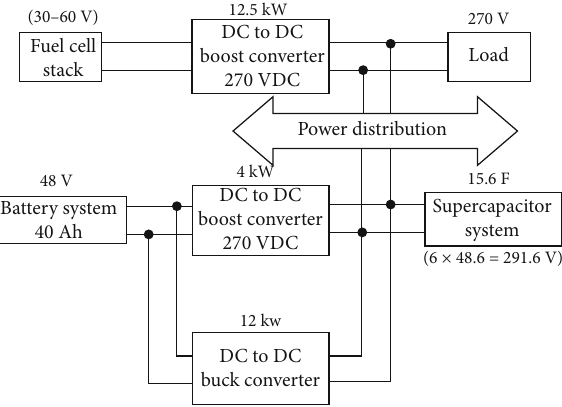
Figure 2: Block diagram for power system on-board